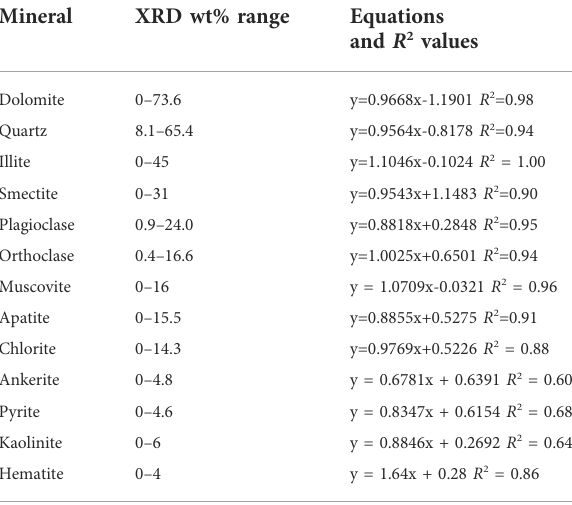
TABLE 1 Equations and R 2 values of trend lines in Figures 3C,D.